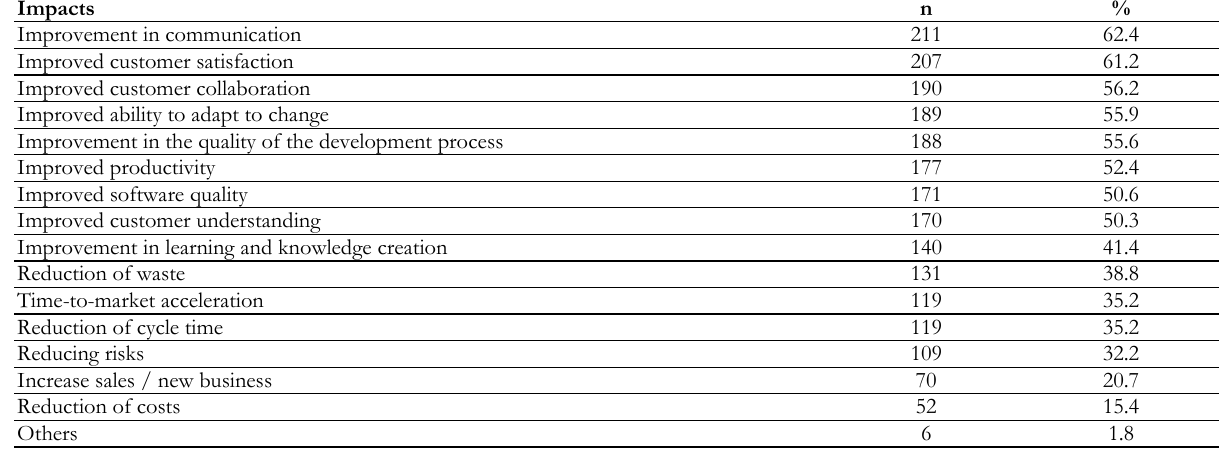
Table 9. Challenges in Adopting